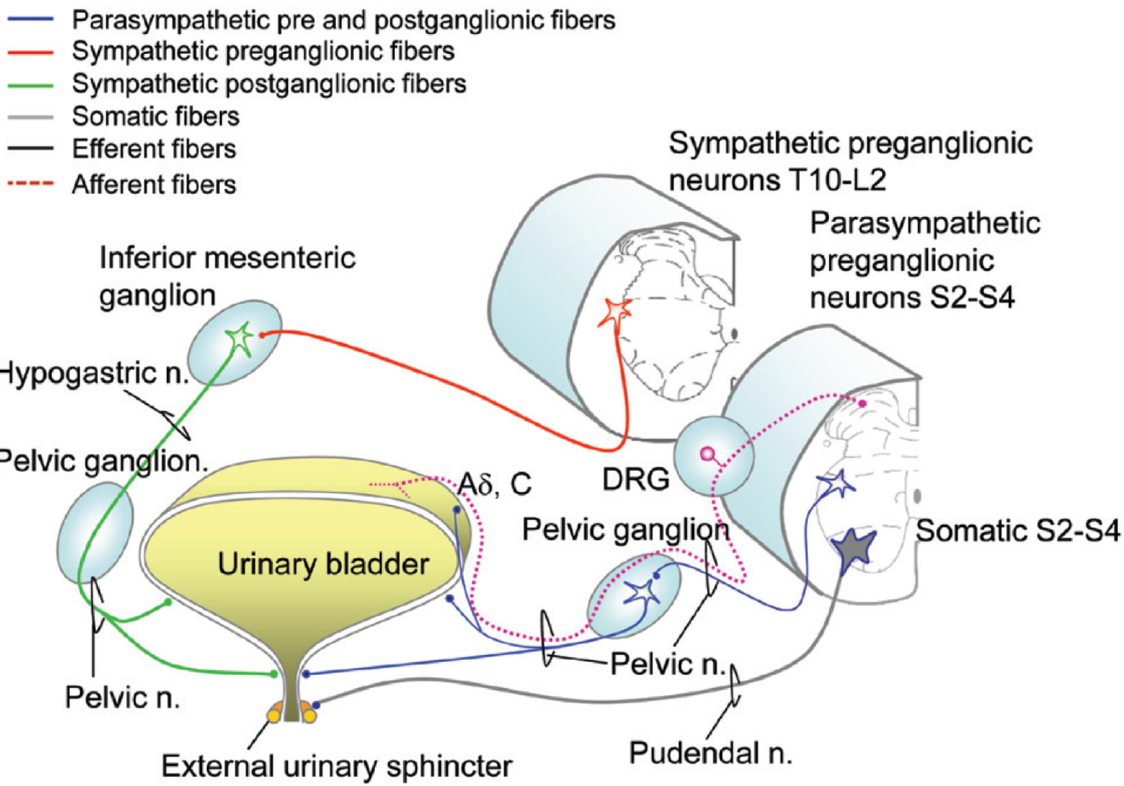
Figure 1. Innervation of the lower urinary tract. DRG: dorsal root ganglion; A δ and C stretch fibers: mechanosensitive afferents. Adapted with permission from Ref. [4]. 2021, Wecht et al.